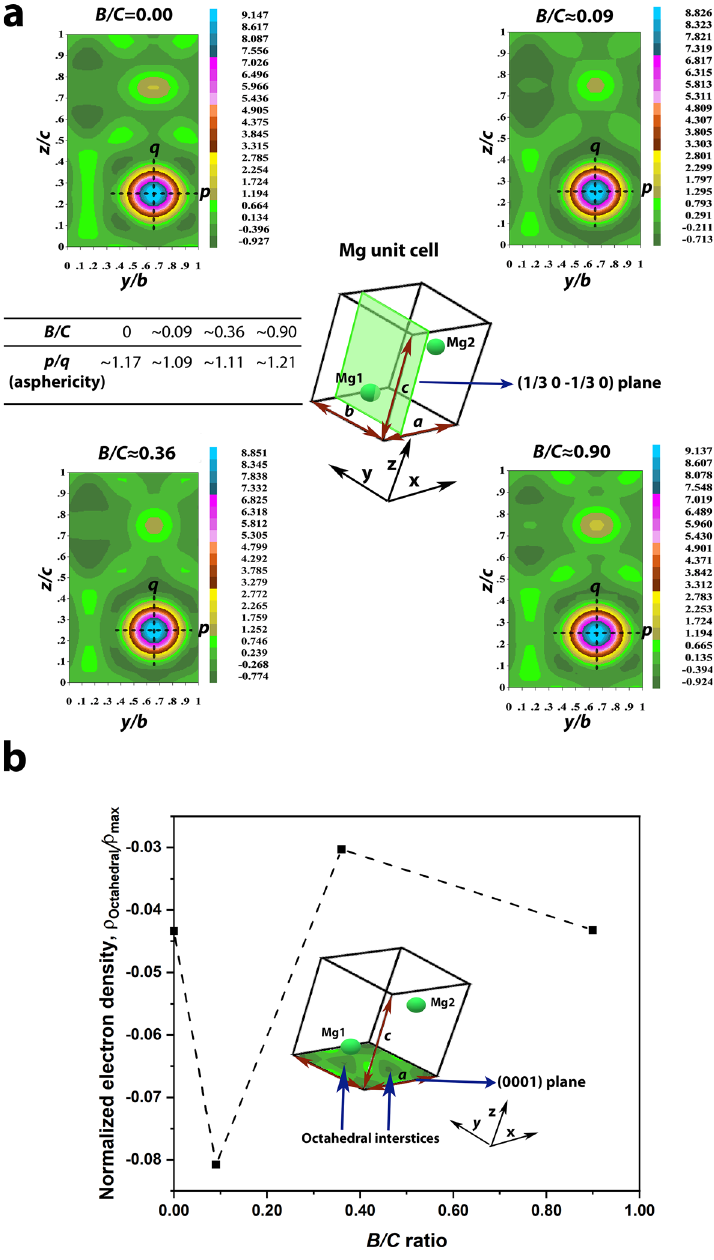
Figure 3. ( a ) Electron density maps corresponding to Mg (1/3 0 –1/3 0) plane and asphericity ( p/q ) of charge distribution around Mg1 atom at various B/C ratios; ( b ) Normalized electron density ( ρ Octahedral /ρ max ) at octahedral sites in Mg (0001) plane plotted against B/C ratio for ball milled Mg-B-erGO